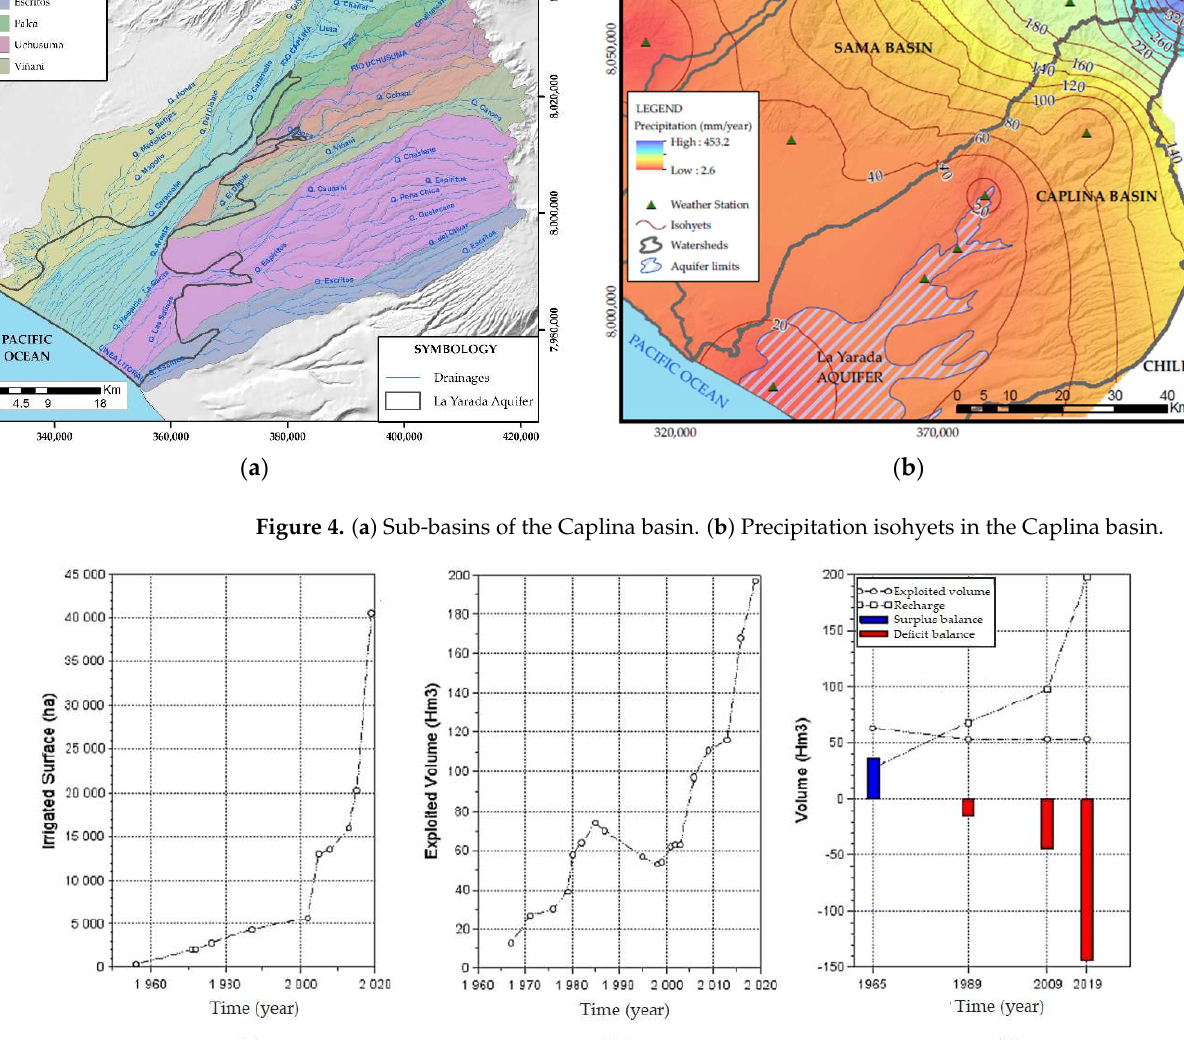
Figure 4. ( a ) Sub-basins of the Caplina basin. ( b ) Precipitation isohyets in the Caplina